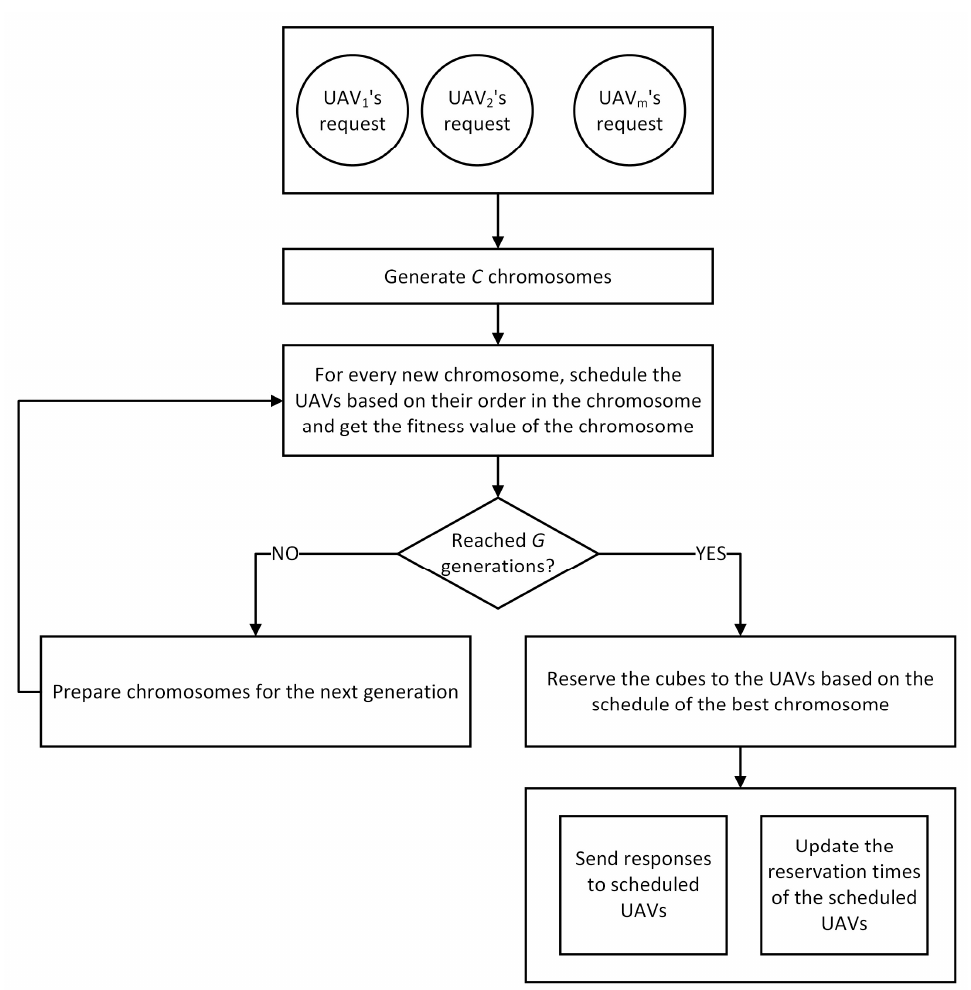
Figure 8. Summary of the tasks of the intersection manager every 𝑘∆𝑡 .